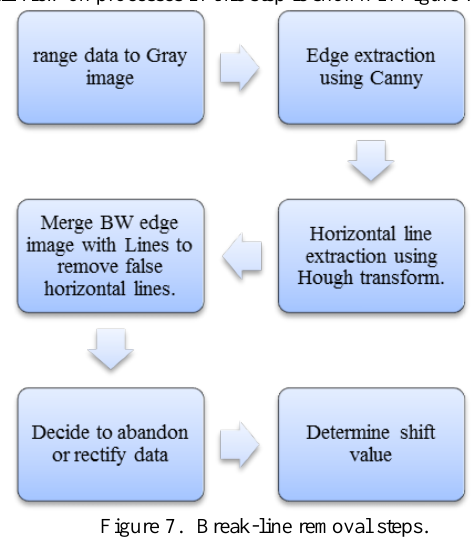
Figure 7. Break-line removal